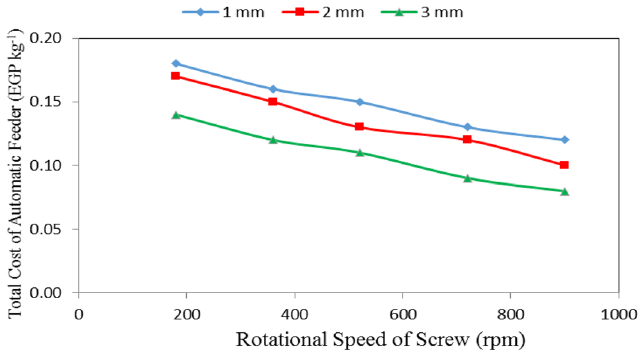
Figure 13. Total cost of automatic feeder at different feed pellet sizes and rotational speeds of screw.